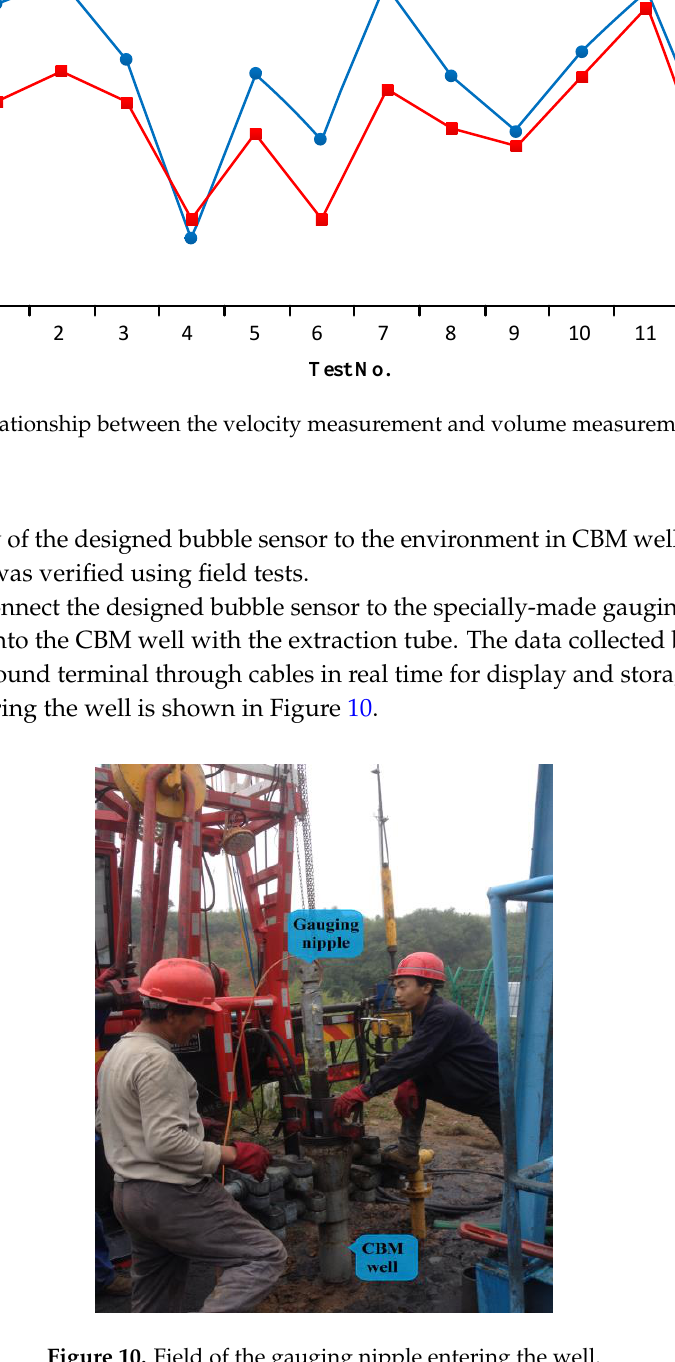
Figure 10. Field of the gauging nipple entering the well.